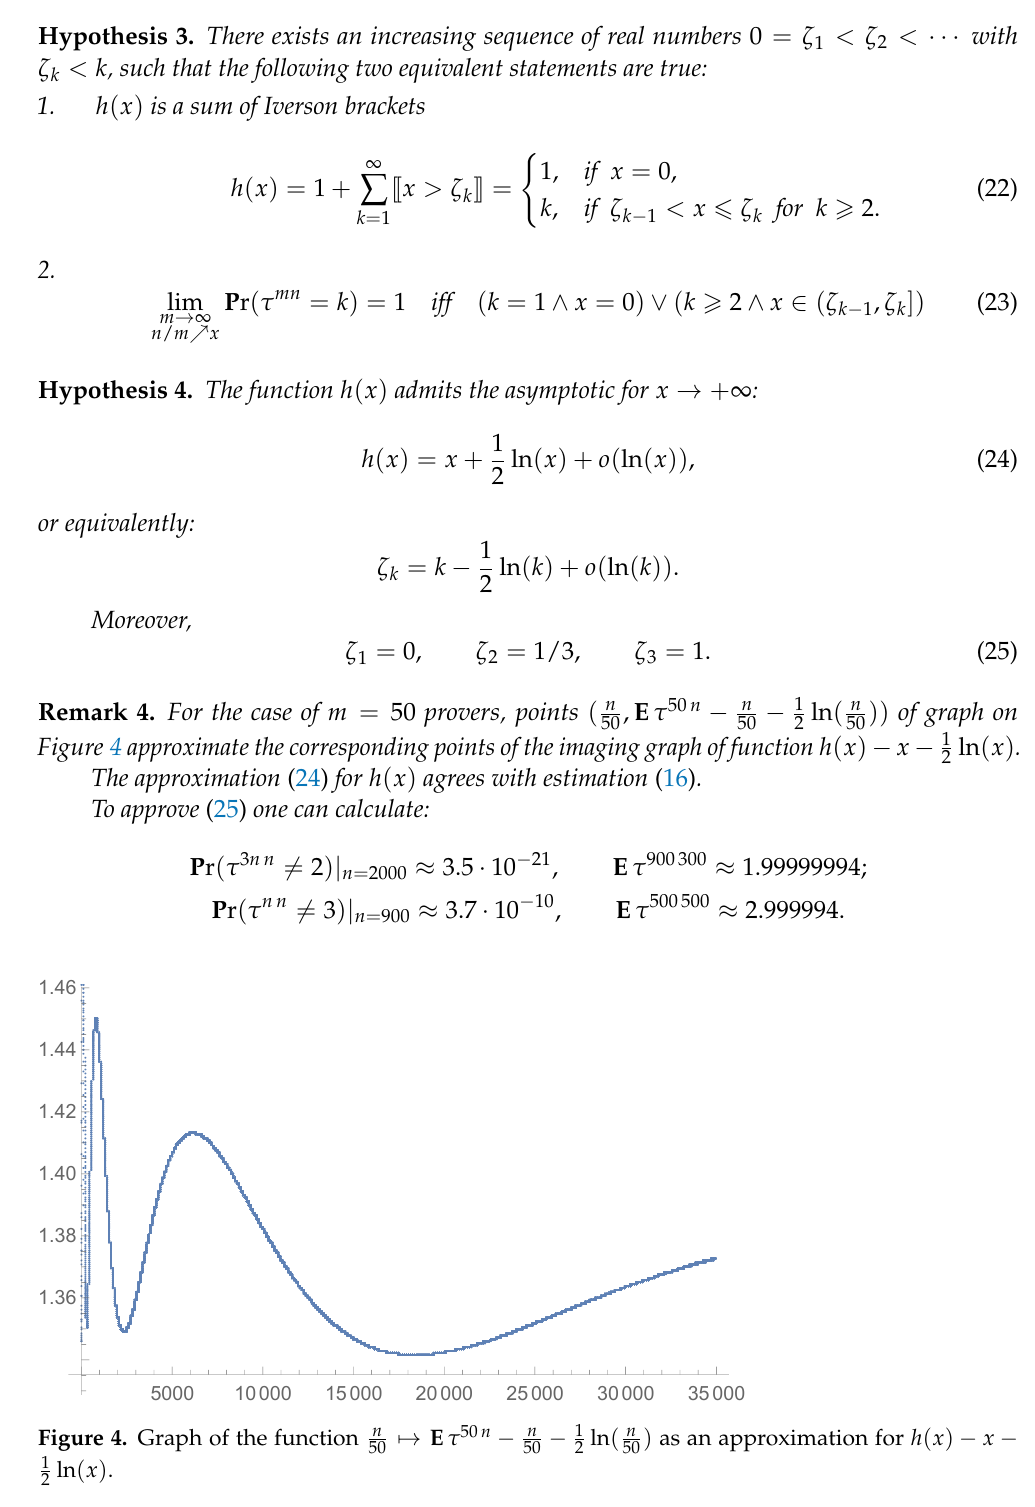
(cid:55)→ E τ 50 n − n 50